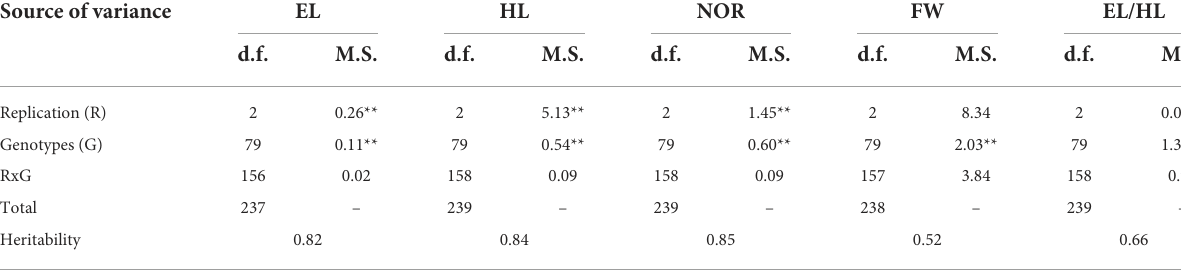
TABLE 3 Mean square (M.S.) of epicotyl length (EL), hypocotyl length (HL), number of radicles (NOR), and fresh weight (FW) under 50% salt treatment in a set of 80 wheat genotypes. Source of variance